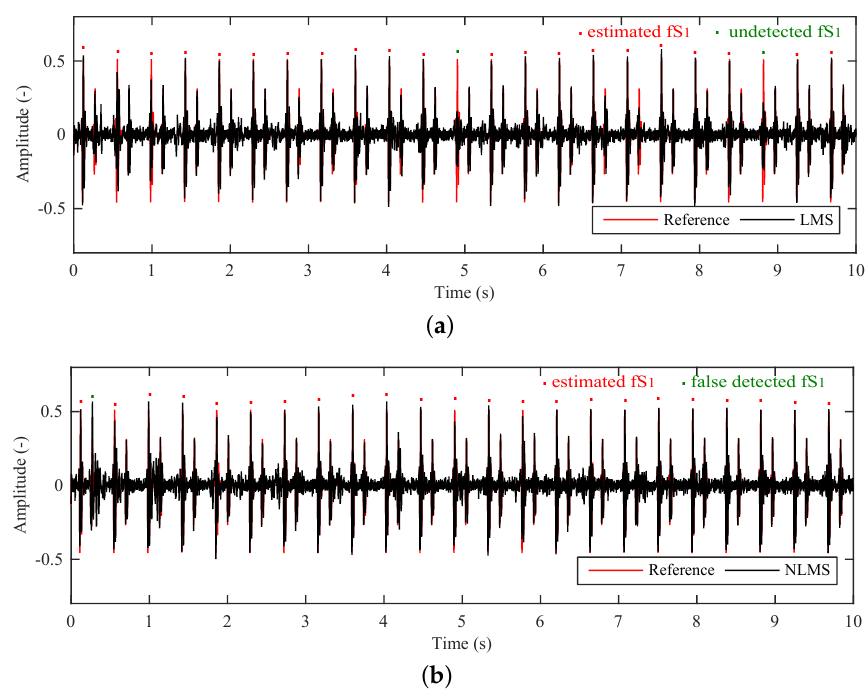
Figure 11. Output of the adaptive system when using ( a ) the Least Mean Square Algorithm (LMS) and ( b ) the Normalized Least Mean Square (NLMS)